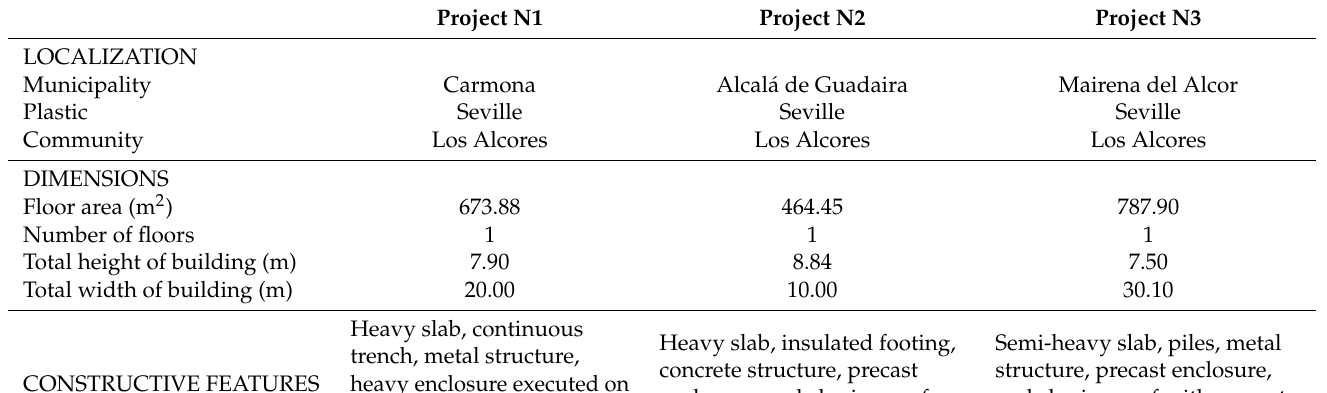
Table 3. Description of case studies.